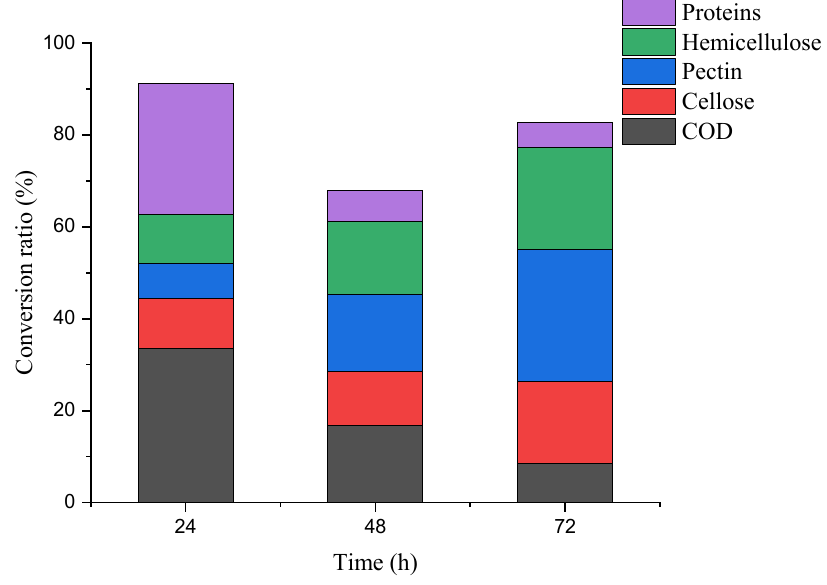
Figure 3. Component changes of sediment composition changes. Error bars show a standard error from triplicate observations.